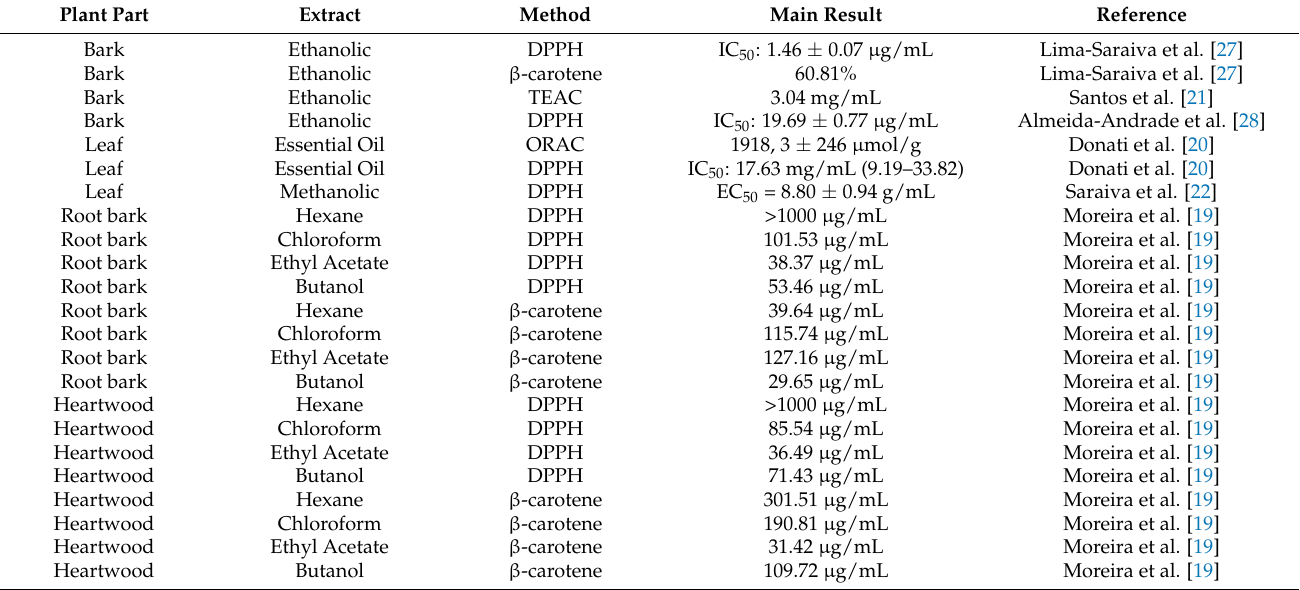
Table 5. Antioxidant activity of Schinopsis brasiliensis .